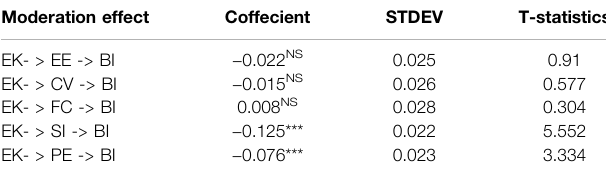
TABLE 7 | Moderation analysis for